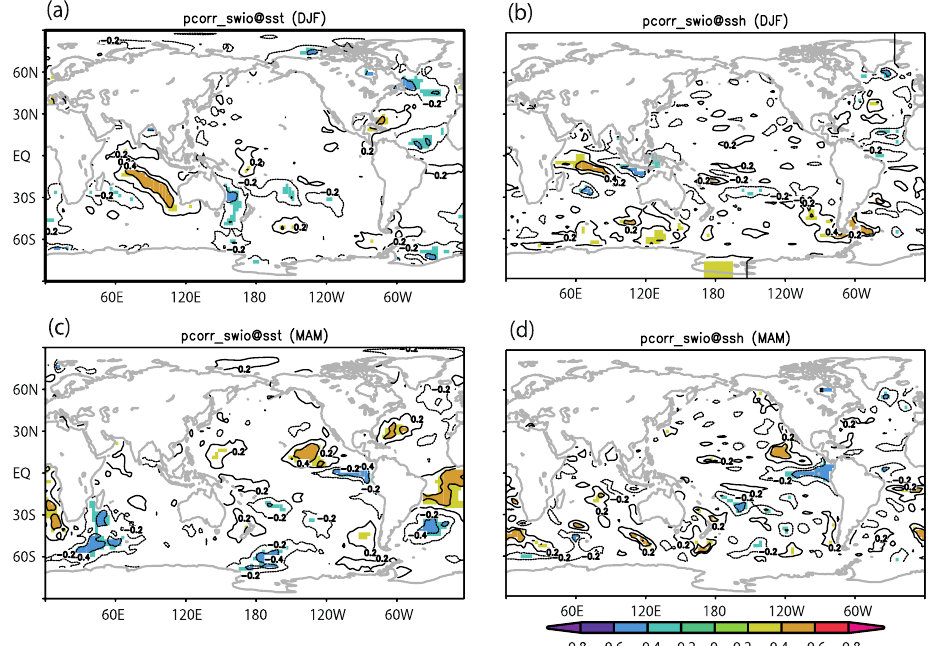
Figure 14. Same as Figure 2 but removed Niño-3 index for partial correlation map. ( a ) DJF SST, ( b ) DJF SSH, ( c ) MAM SST, ( d ) MAM SSH. ( b ) DJF SSH, ( c ) MAM SST, ( d ) MAM